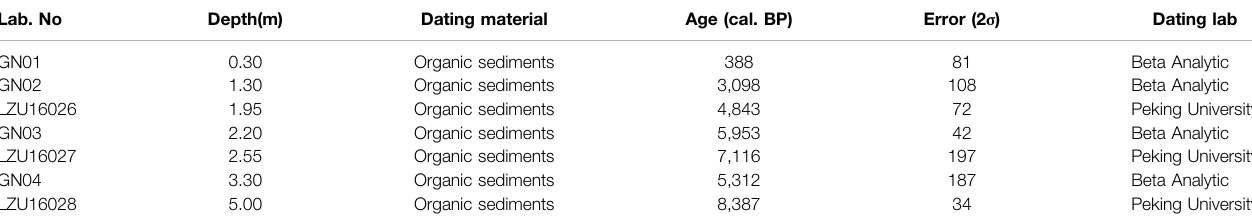
TABLE 1 | Accelerator mass spectrometry radiocarbon dating results of the MQQ pro fi le by depth. Lab.